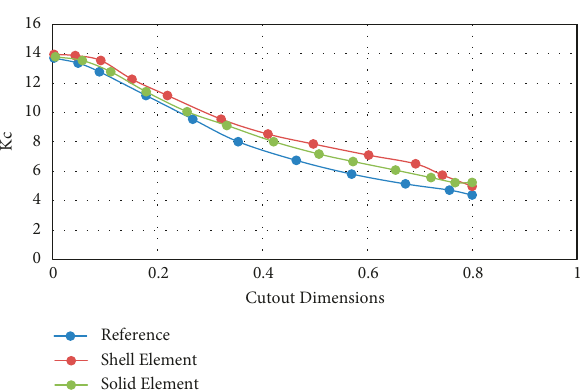
Figure 7: Results from shell and solid elements.